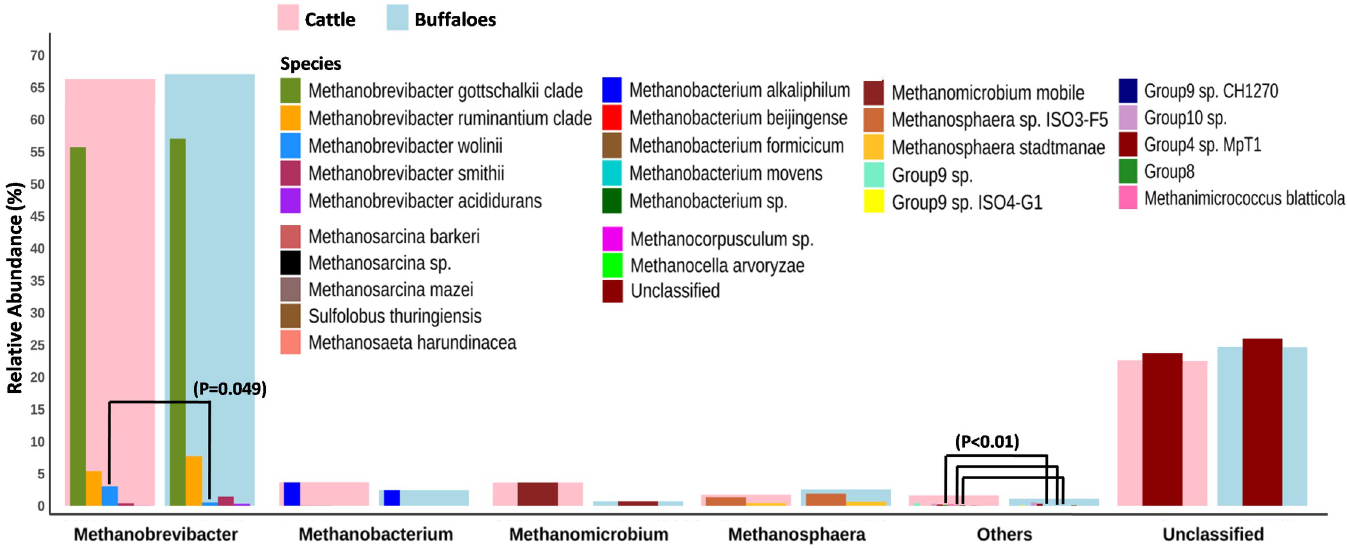
Fig 2. Ruminal archaea community composition at genus and species levels in cattle and buffaloes. Each genus is represented by larger bars that are underlaid on the smaller bars representing the abundance of all the species affiliated to the corresponding